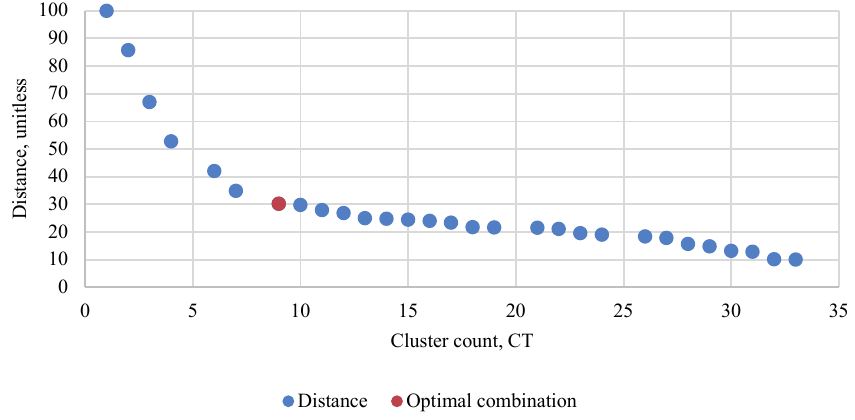
Fig. 7. Distance vs Cluster count of multiplied